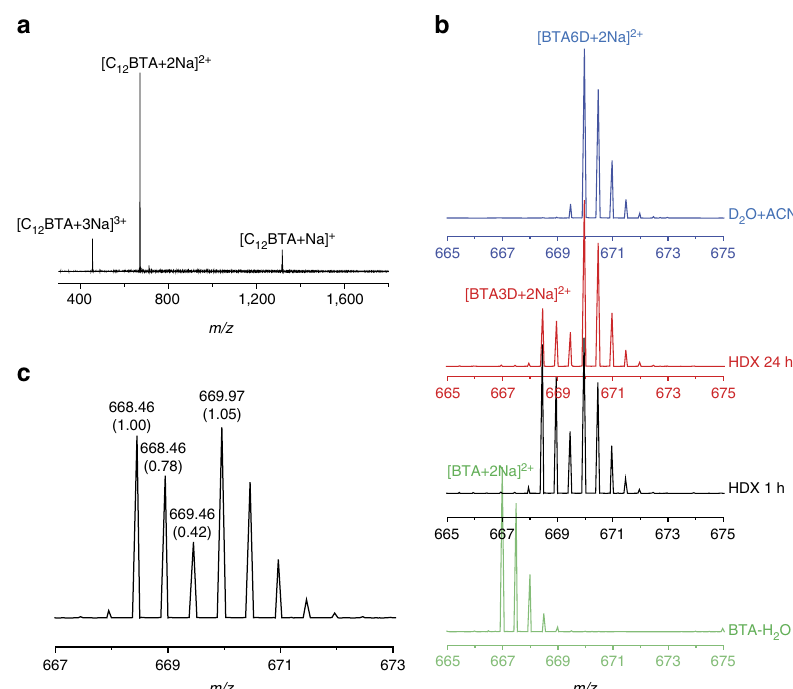
Figure 2 | Mass spectra during the exchange reaction. ( a ) ESI-MS spectrum of C 12 BTA with the doubly charged ion as the most prominent ion. ( b ) HDX-MS spectra of doubly charged sodium adducts of C 12 BTA obtained after the dilution of a 500 m M C 12 BTA-H 2 O solution 100 times into D 2 O or H 2 O. The spectra at four different stages are presented in different colours. The green spectrum is a reference spectrum of C 12 BTA diluted into H 2 O; the black spectrum and the red spectrum are recorded after HDX for 1 and 24h, respectively; the blue spectrum is the spectrum of a control measurement where the polymers were diluted 100 times into a solvent mixture containing acetonitrile (ACN/D 2 O ¼ 1/1 (v/v)). ( c ) Mass spectrum obtained after the dilution of a 500 m M C 12 BTA-H 2 O solution into D 2 O and HDX for 1h. The numbers in the round brackets are the corresponding relative intensities.